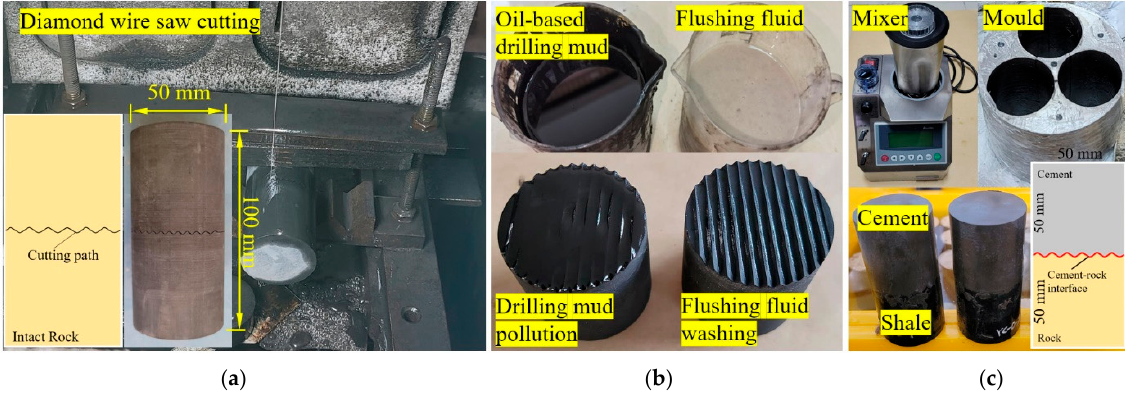
Figure 2. Preparation steps of rock–cement composite specimens. ( a ) Cutting rock with diamond wire saw, ( b ) Rock surface pollution and flushing, ( c ) Cement pouring and curing.